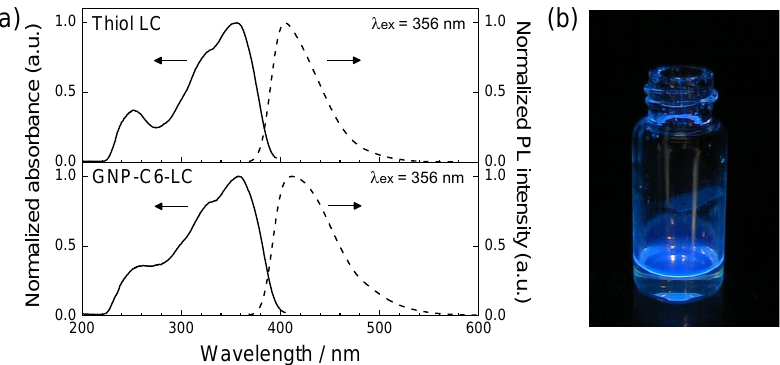
Figure 5. ( a ) Normalized absorbance (solid line) and emission spectra (dashed line) of the thiol LC and GNP-C6-LC in CH 2 Cl 2 (1.0 × 10 − 6 M) and ( b ) the CH 2 Cl 2 solution of GNP-C6-LC under UV light.